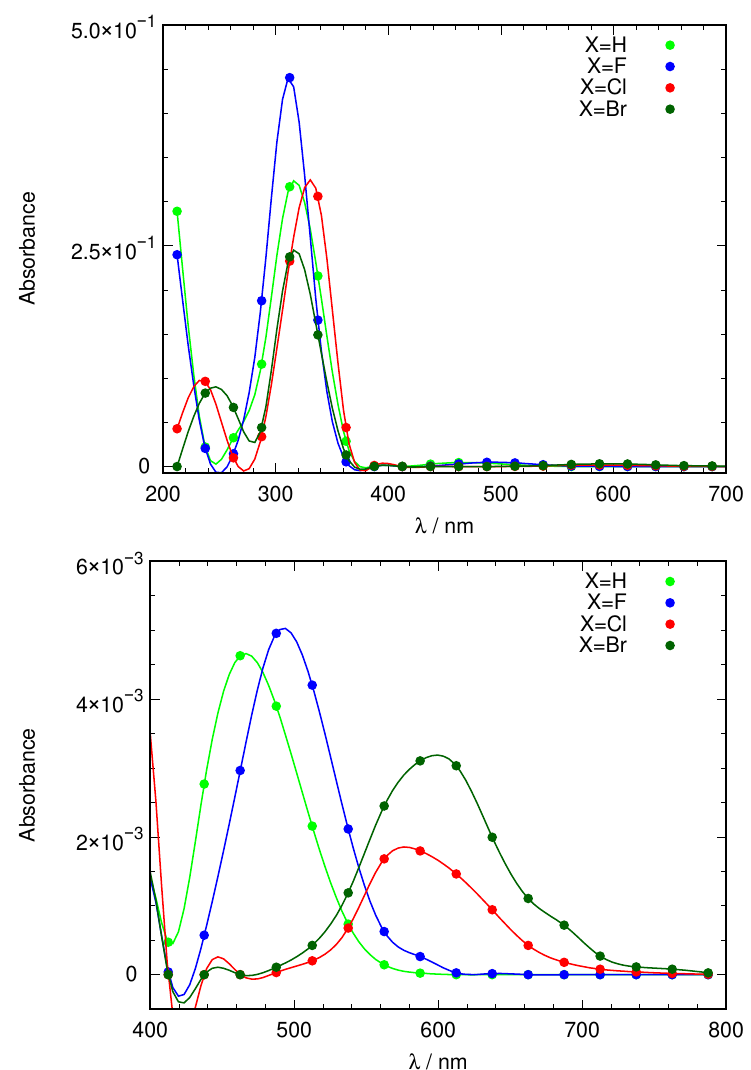
Figure 10. Simulation of the absorption spectra of azobenzene derivatives (X=H, F, Cl, Br) based on a 30 ns QM/MM molecular dynamics simulation where the solute is described using DFTB. Top: full range including UV and visible spectra; Bottom: visible part of the spectrum highlighting the weak transition to S 1 . Absorption is given in arbitrary